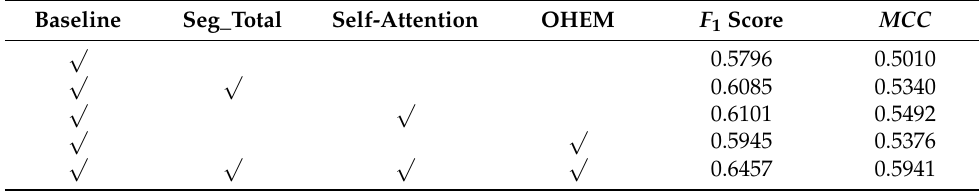
Table 3. The average F 1 scores of proposed method on the CASIA v1.0